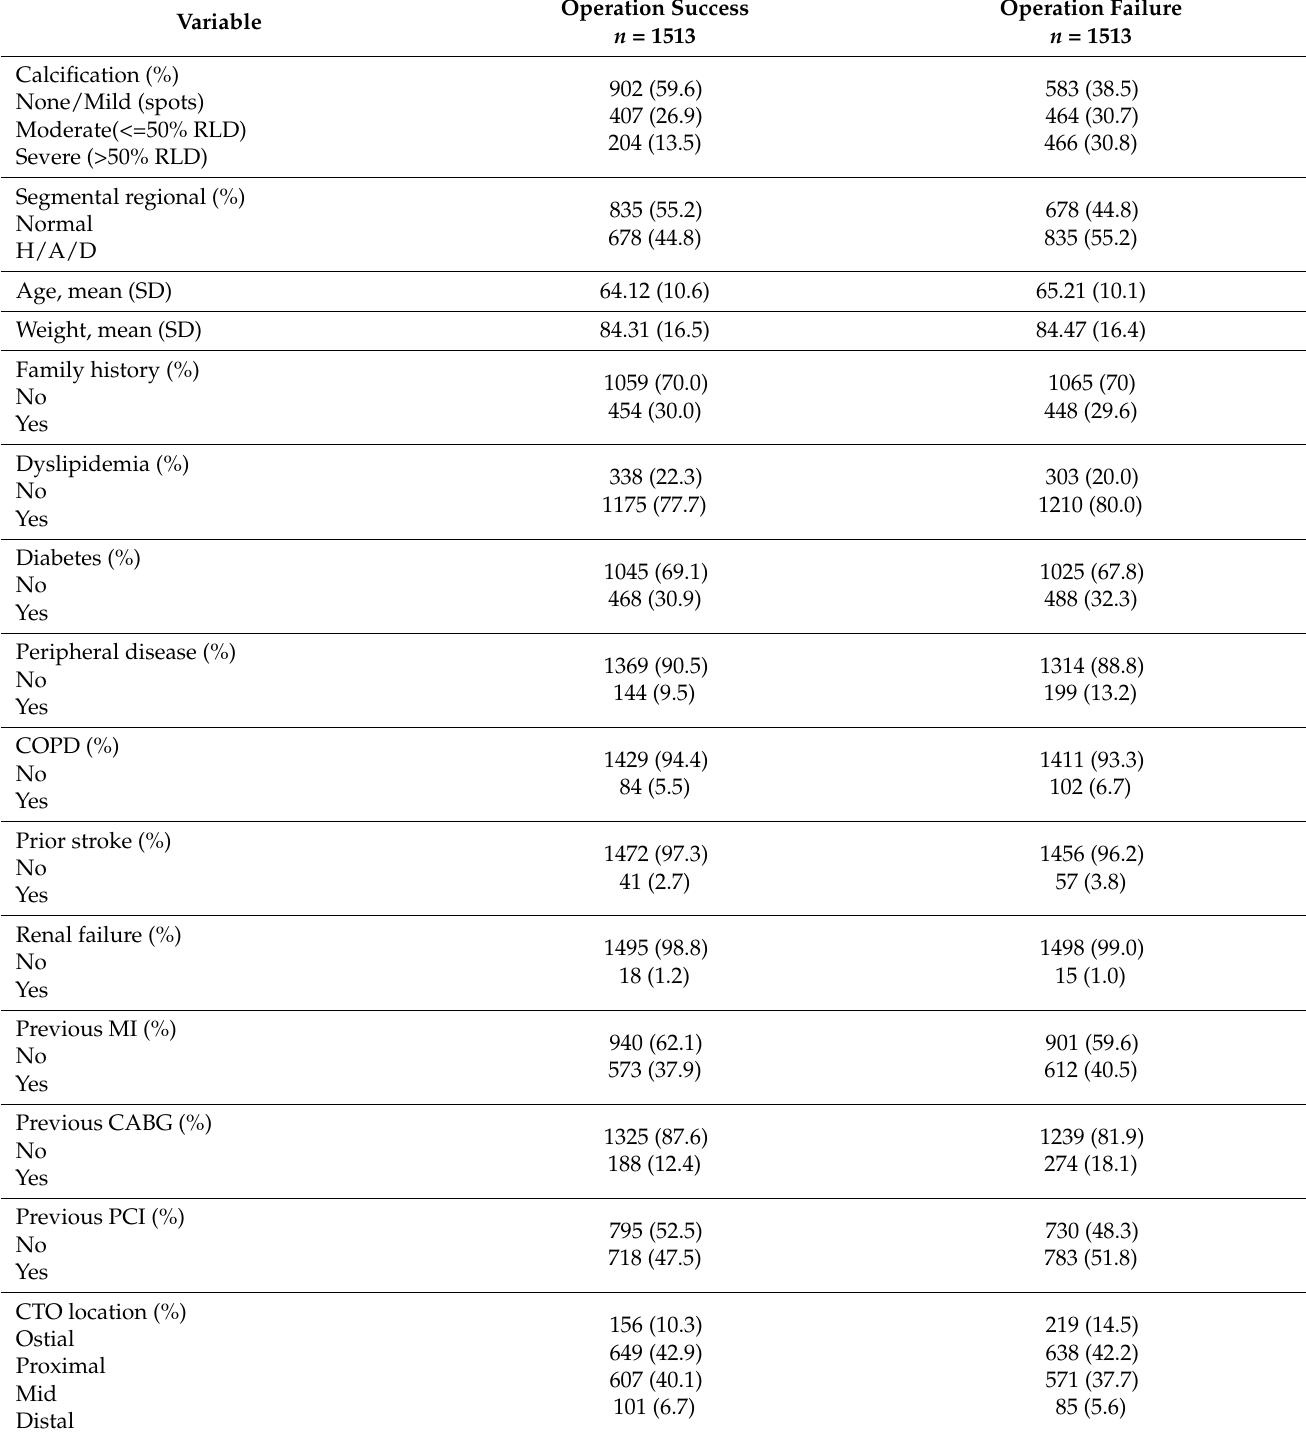
Table A1. Descriptive characteristics for the downsampled training dataset ( n = 3026). For quantitative variables, the mean and standard deviation (in brackets) are displayed. For qualitative variables, the frequencies and corresponding percentages (in brackets) are displayed for each